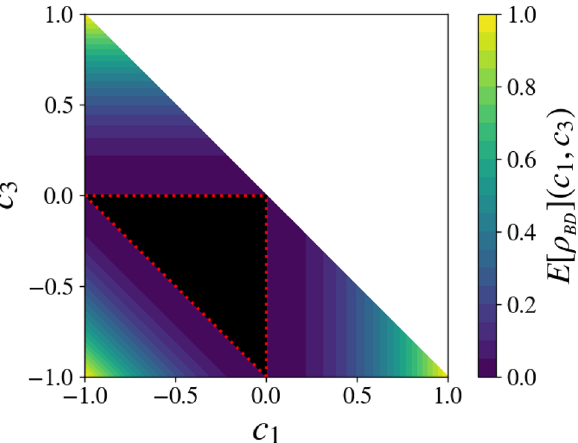
ρ BD ( c 1 , c 2 c 1 , c 3 )/ 2 for a face of the BD state tetrahedron T , Figure 2. Entanglement distance E [ ] = corresponding to a mixture of three Bell states. The red dotted line defines the smaller triangle where the state is separable, according to the PPT criterion 26,27 and a number of alternative derivations available in the literature (see e.g. 24 ). Values below the threshold of 10 − 3 have been represented in black to emphasize that they correspond to a numerical zero, given the level of precision allowed by such time-costly minimization. The vertices of the large triangle correspond to pure Bell states, and those of the smaller black triangle to equal-weight mixtures of two Bell